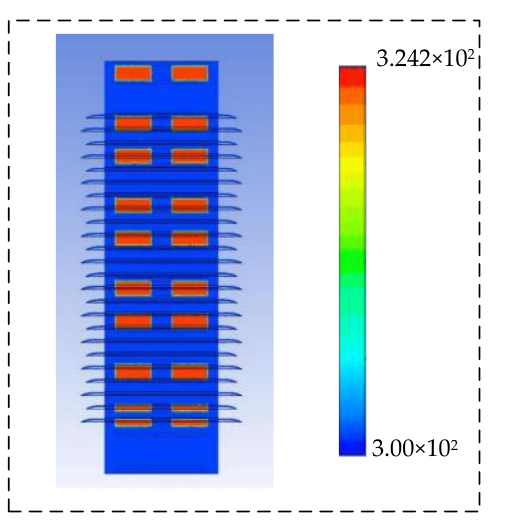
Figure 11. The transient temperature distribution of the arrester under the operating condition of fault f18.